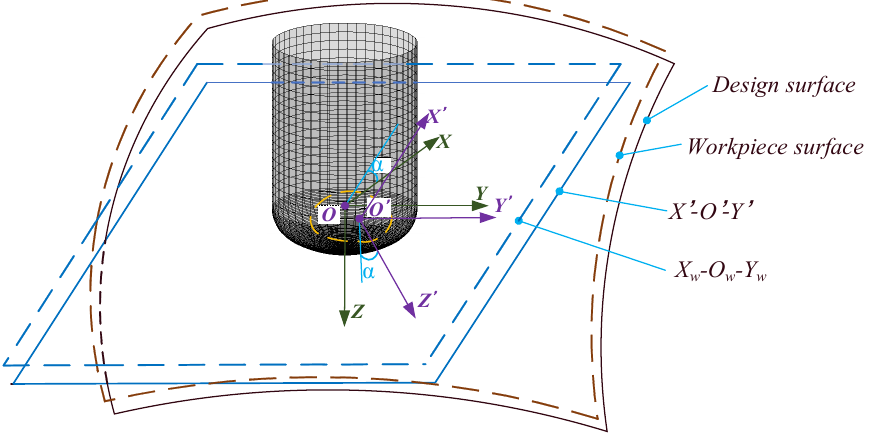
Figure 4. Geometric contact relationship.